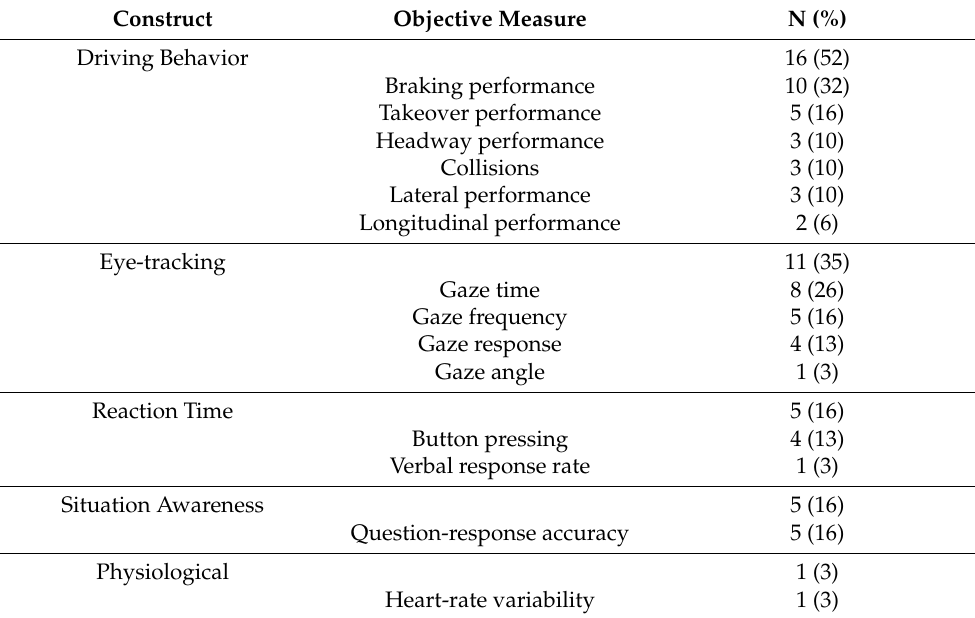
Table 3. Summary of administered objective